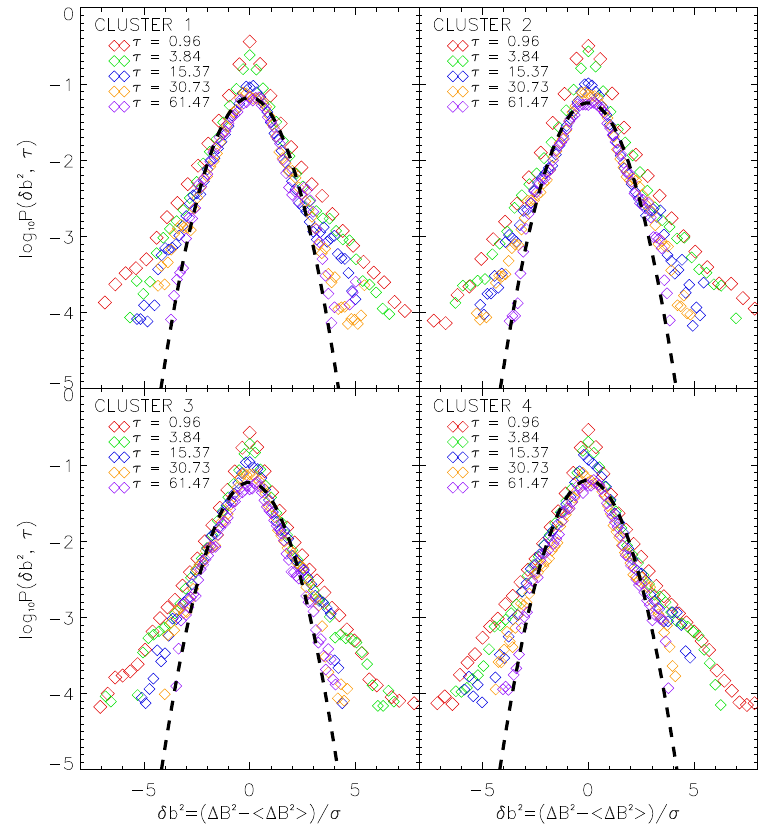
Fig. 5. Typical PDFs of the magnetic energy density fluctuations measured by the four Cluster satellites in the cusp; the PDFs have been scaled with respect to their variance. Dashed curves are Gaussian distributions. The scales ( τ ) are color coded and given in seconds.